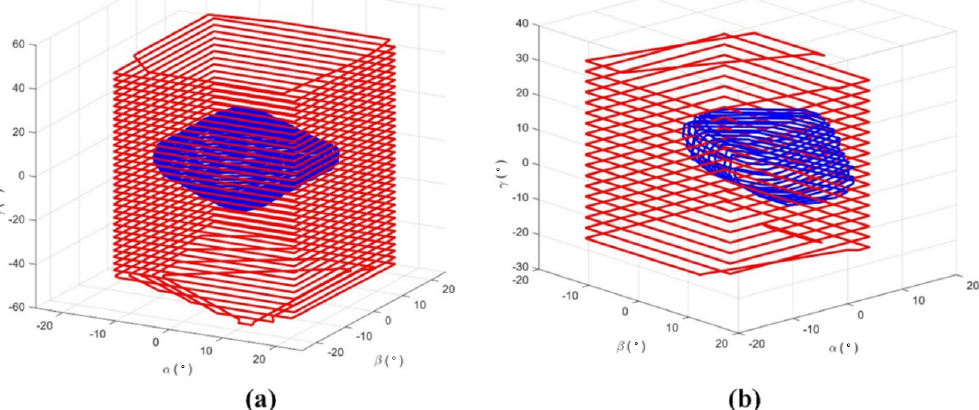
Figure 10. Angular workspace representation of the hybrid mechanism (red) and the Stewart platform (blue) in the ( α , β , γ ) coordinate system at homing position (a) and at bone reduction target position (b)